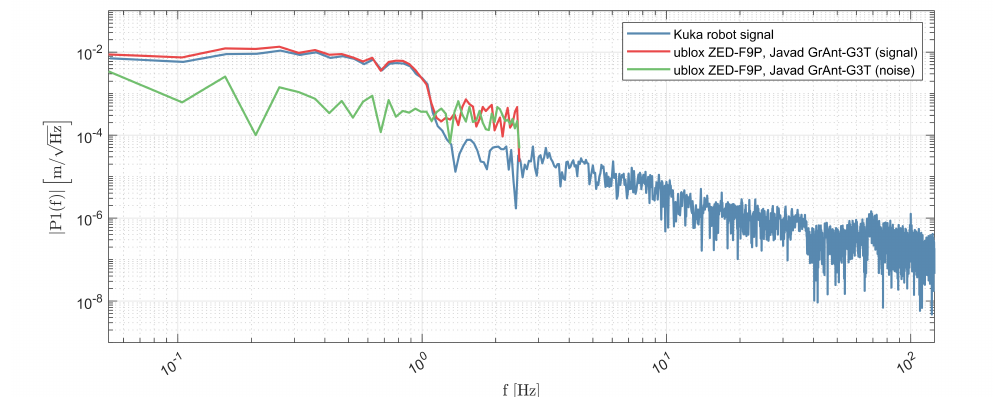
Figure 11. Session 1: one-sided amplitude spectral density of the GNSS height component of the dynamic test: robot ground truth (blue line), GNSS dynamic signal from the u-blox receiver (red line), and pre-event GNSS noise (green